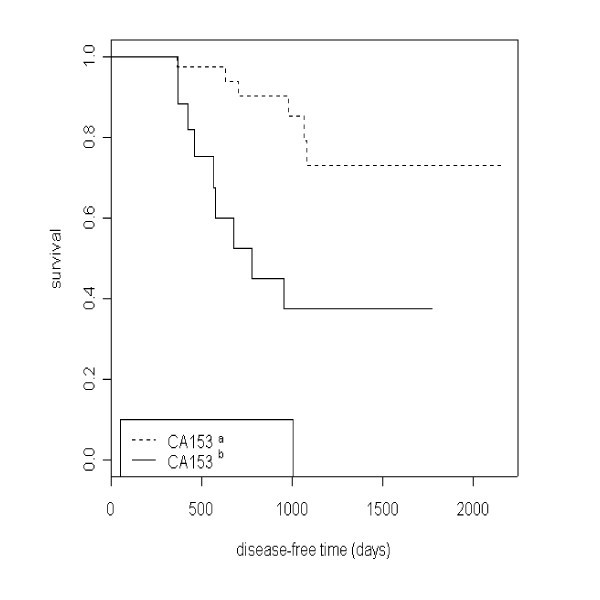
Kaplan-Meiers survival curve shows post PC high serum levels of CA15-3 (CA15-3a levels ≤ 30 KU/L, CA15-3b ≥ 30 KU/L) was associated with early disease recurrence (p = 0.007 Cox model).